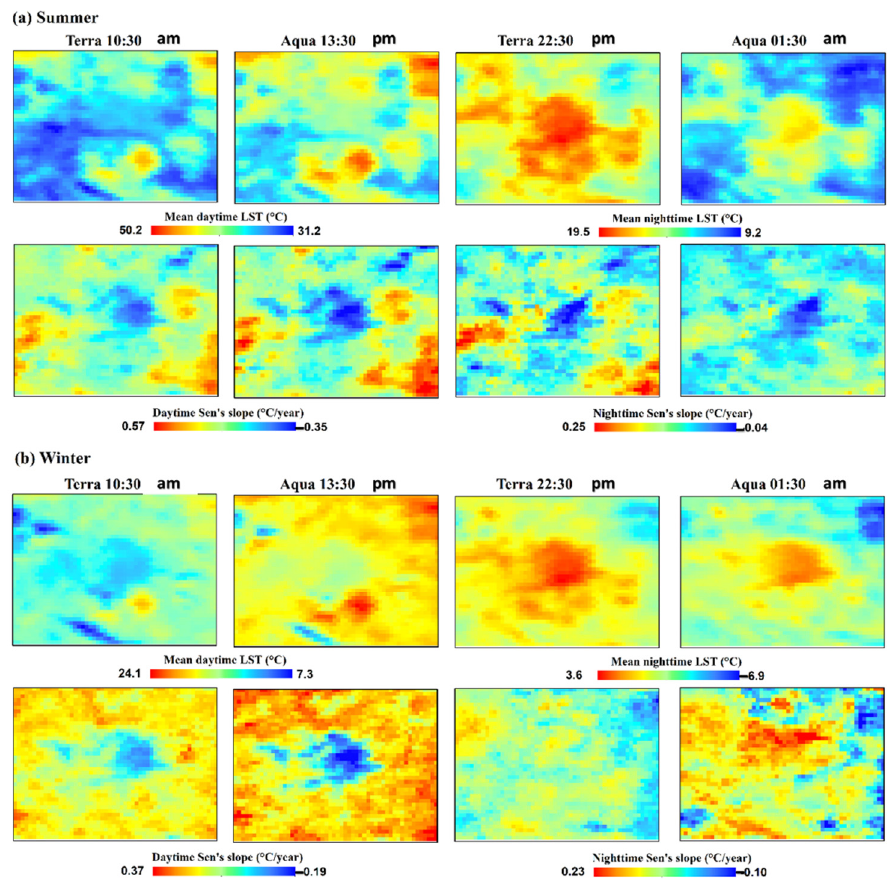
Figure 4. ( a ) Spatial variation of mean summer LST (average over 2003–2019) during daytime (Terra 10:30 a.m. and Aqua 13:30 p.m.) and nighttime (Terra 22:30 p.m. and Aqua 01:30 a.m.) in first row and the value of Sen’s slop for the corresponding LST images in the second row, and ( b ) for the winter season.